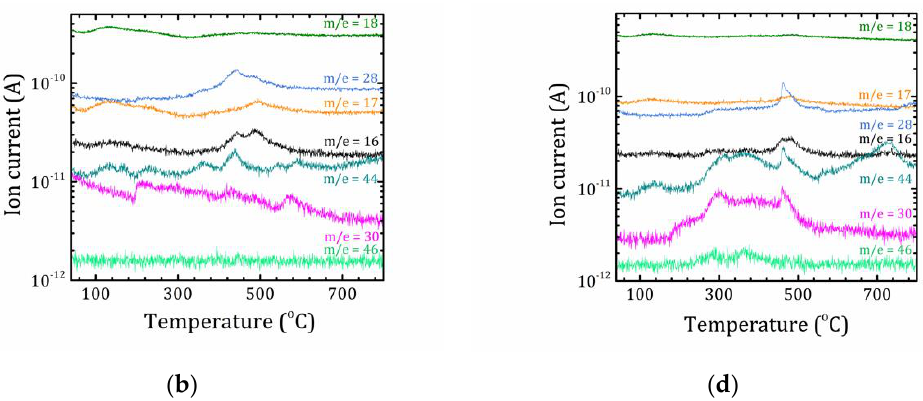
Figure 5. ( a , c ): TG (blue), DTG (violet), DSC (red) and ( b , d ): ion current (various colors) curves for the MOR-AS ( a , b ) and MFI-AS ( c , d ) samples.